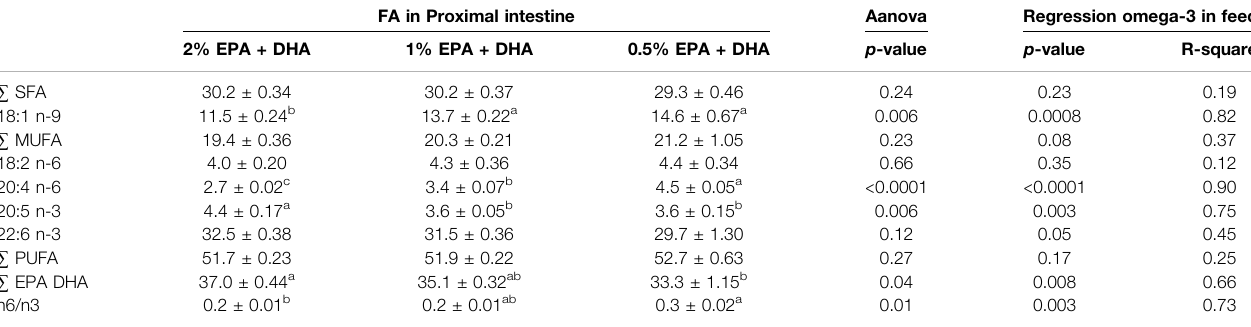
TABLE 4 | Fatty acid (FA) composition (% of total) in the phospholipid (PL) fraction of Atlantic salmon proximal intestine fi rst sampling (5 days after transfer to seawater).